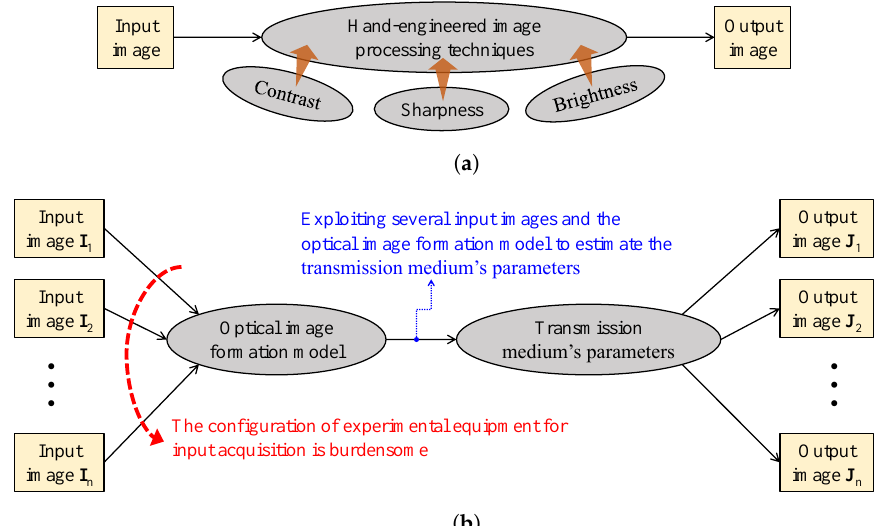
Figure 5. Simplified block diagrams of: ( a ) contrast enhancement and ( b ) polarimetric dehazing approaches in visibility